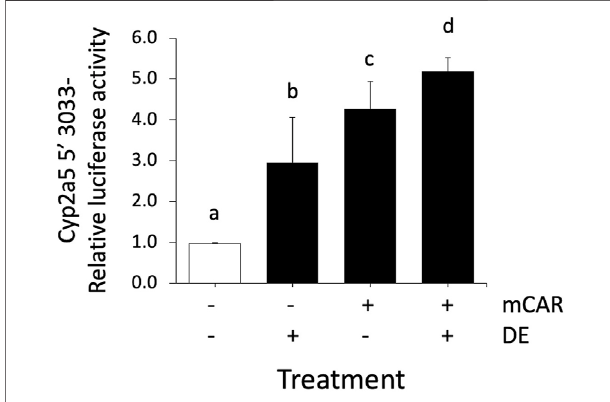
FIGURE 10 | Cyp2a5 induction by DE is increased by CAR overexpression. Cyp2a5-5 ′ -luciferase reporter activities were assessed in primary mouse hepatocytes 24 h after CAR co-transfection, CAR co- transfection followed by 50 μ M DE or DE treatment alone for 24 h. The measured activities were normalized against Renilla (pRL-TK) activities. All values represent the mean ± SEM (n (cid:2) 4). Bars with different letters are signi fi cantly different ( p ≤